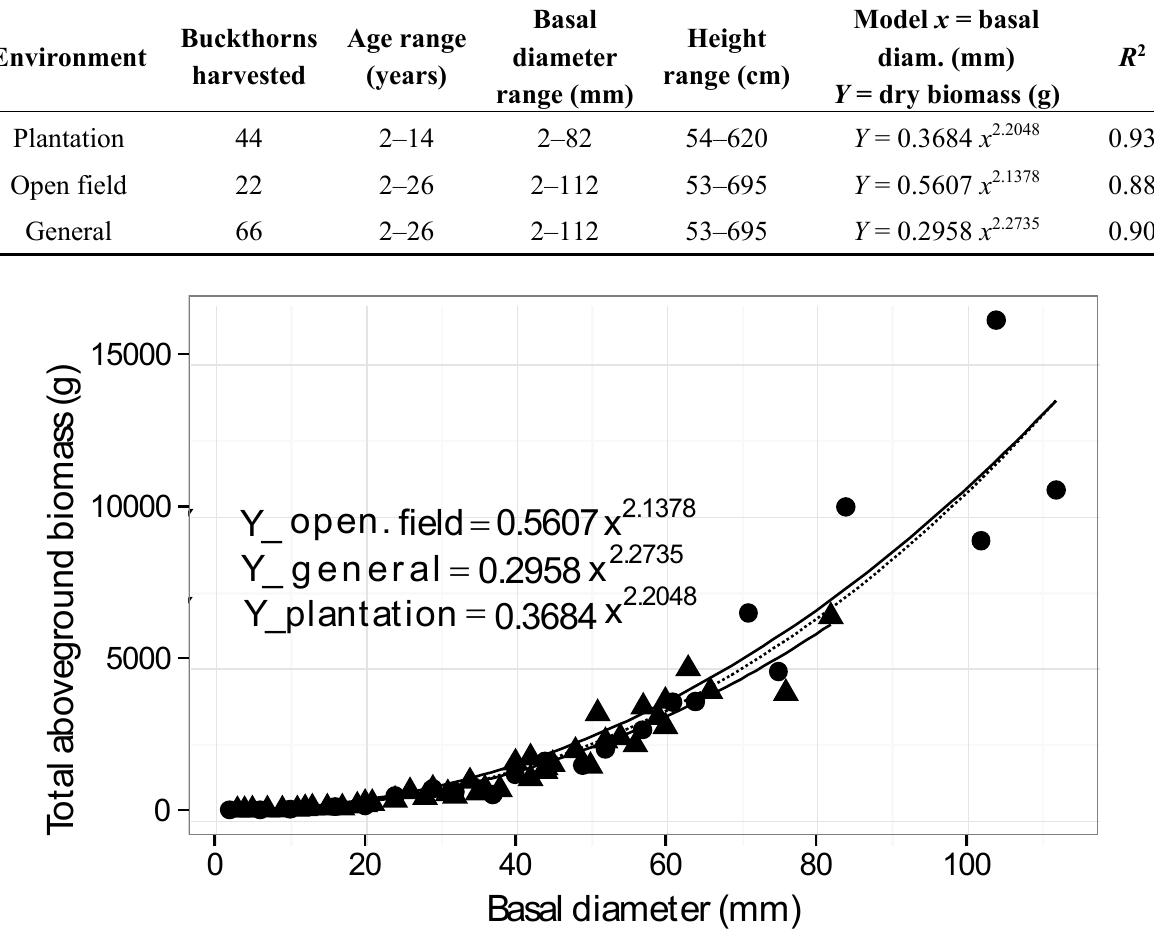
Figure 3. Environment-specific relationships and general allometric relationship for glossy buckthorn between basal diameter (mm) and total aboveground biomass (g). Triangle symbols = Plantation data points; Circle symbols = Open field; Dotted line = general model (plantation + open